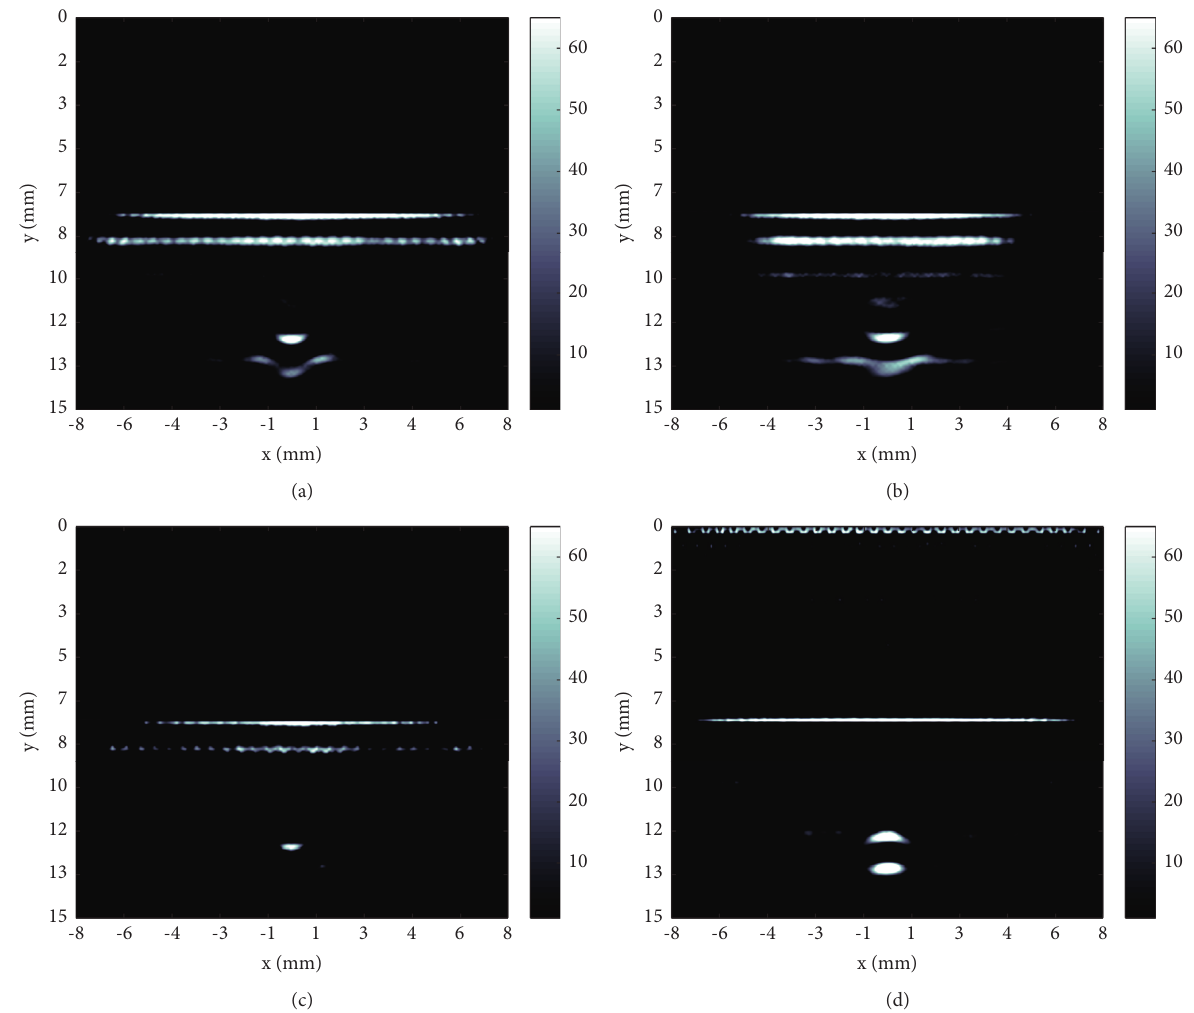
Figure 7: Focused imaging of model 1: (a) ML-TFM; (b) ML-SFM-1 (in equation (4), j � 7 : 23); (c) ML-SFM-2 (in equation (4), j � 1 : i ); (d)